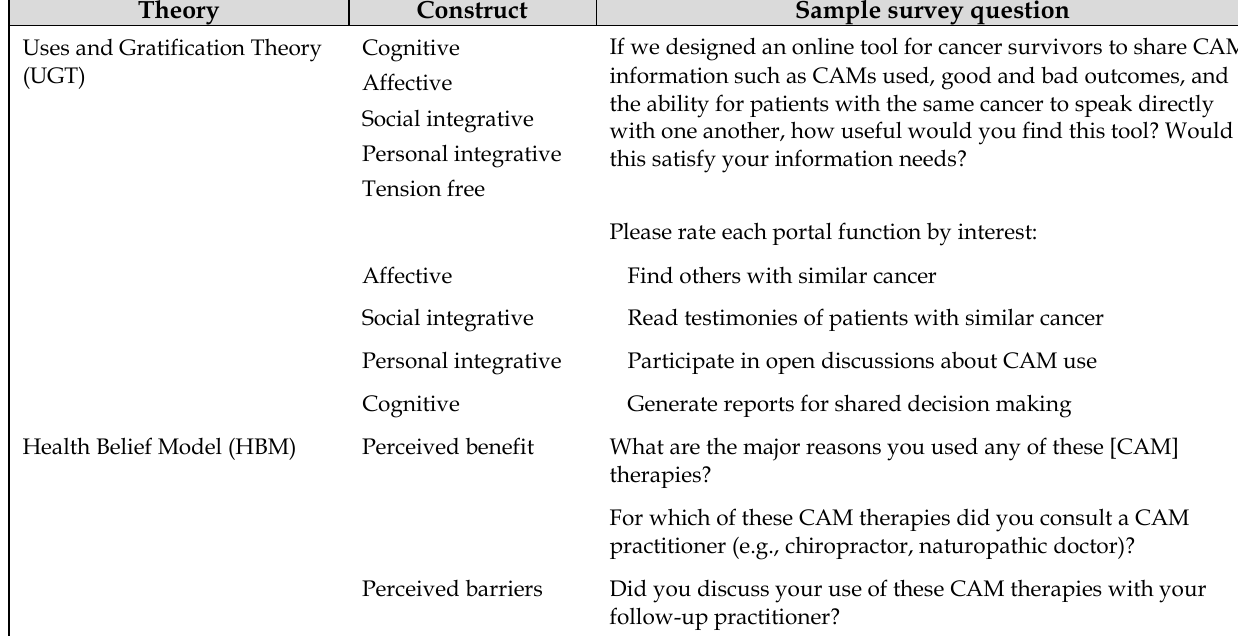
Table 1 Theory, constructs, and sample survey questions Theory Construct